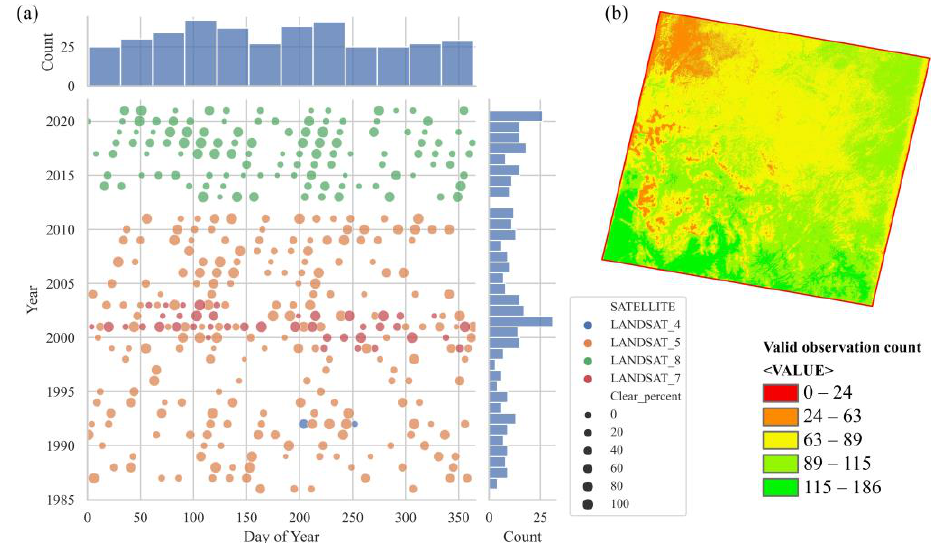
Figure 2. ( a ) The temporal distribution of Landsat image acquisition across the day of year and year, with the image quality denoted as the size of dots. ( b ) The spatial distribution of valid observations during 1986 – 2021.